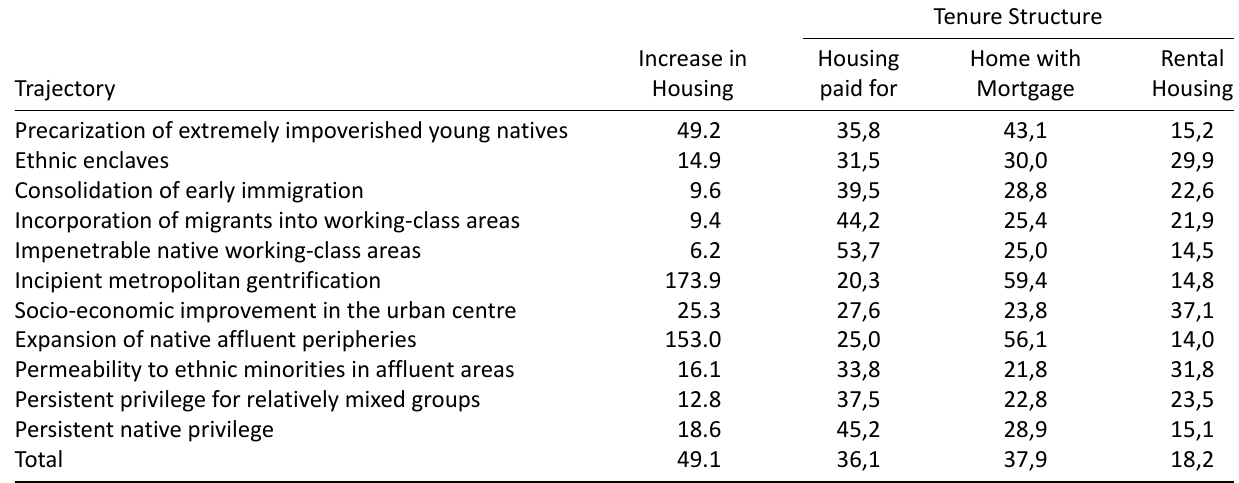
Table 6. Relative increase of main dwellings (2001–2011) and tenure structure (2011) according to the type of social resi- dential